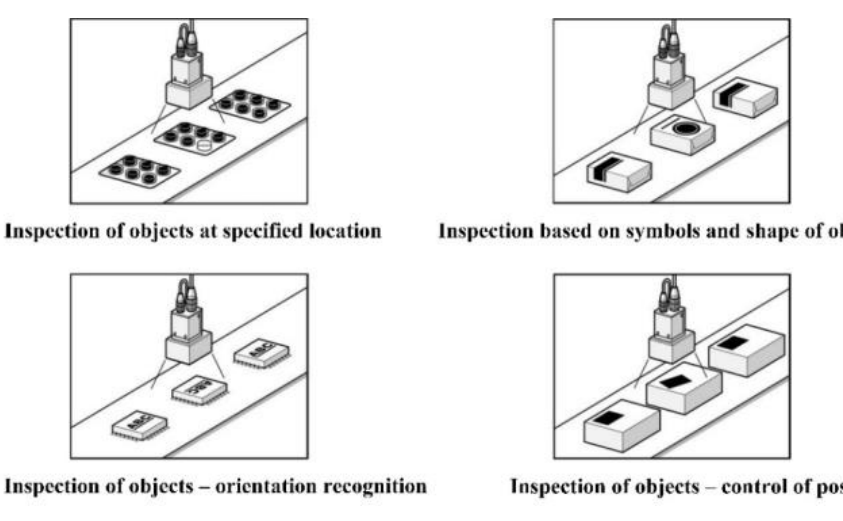
Figure 1. Purpose of cameras.